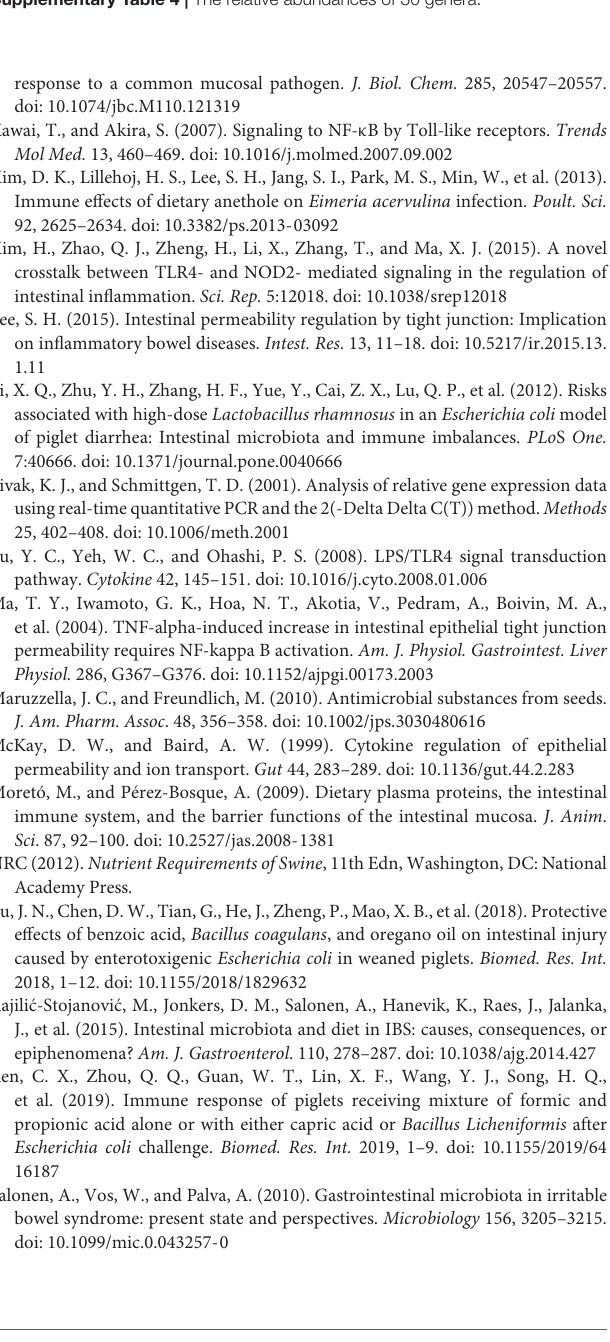
Supplementary Figure 1 | The experimental procedure. Supplementary Table 1 | Composition and nutrient levels of basal diets (as fed-basis). Supplementary Table 2 | Primer sequences of target and reference genes. Supplementary Table 3 | The relative abundances of 8 phyla. Supplementary Table 4 | The relative abundances of 30